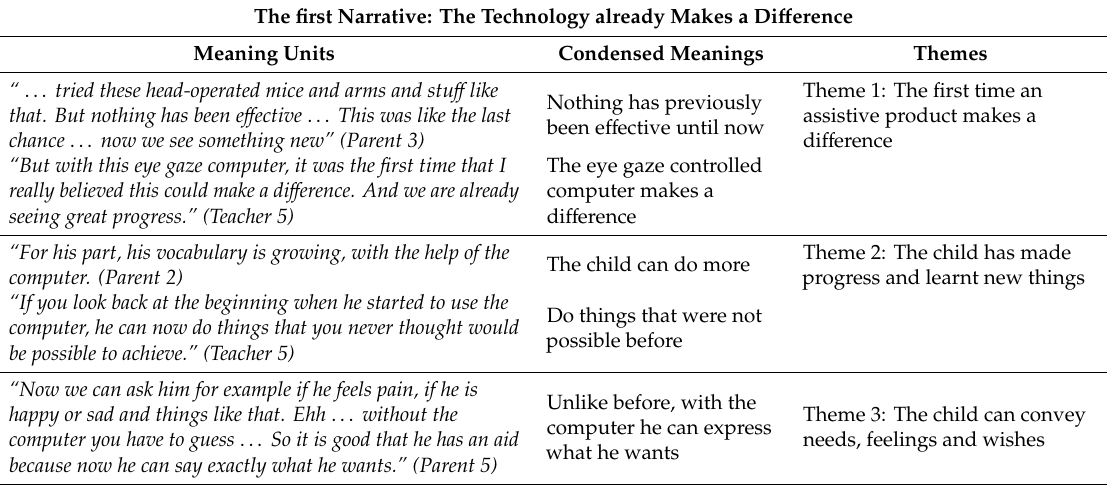
Table 2. Themes and examples of connected meaning units and condensed meaning in the first